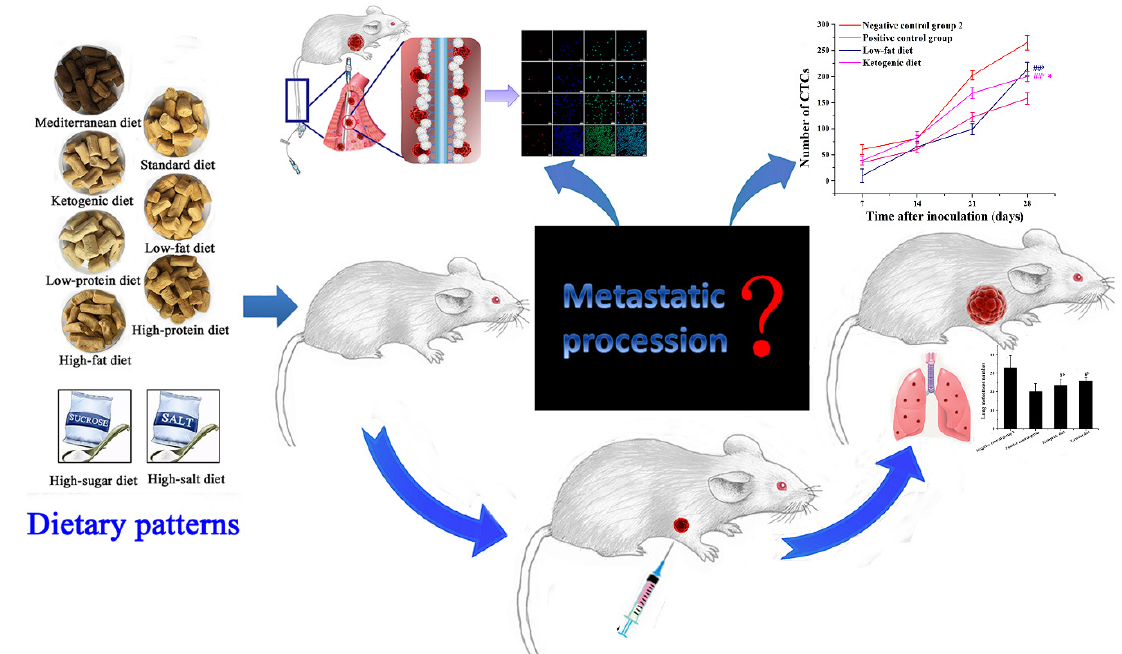
Scheme 1. A Schematic model of effects of different dietary patterns on breast cancer metastasis based on in vivo capture of CTCs. #b p < 0.05 and ##b p < 0.01 compared with negative control group 2. * p < 0.05 compared with that of positive control group.